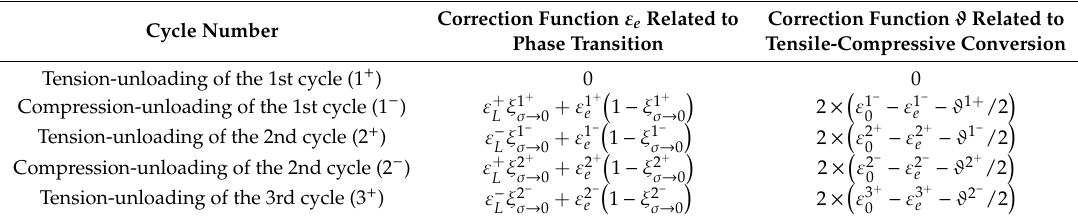
Table 1. Evolution of the accumulated correction functions ε e and ϑ for multiple cycles. Correction Function ε e Related to Correction Function ϑ Related Cycle Number Phase Transition